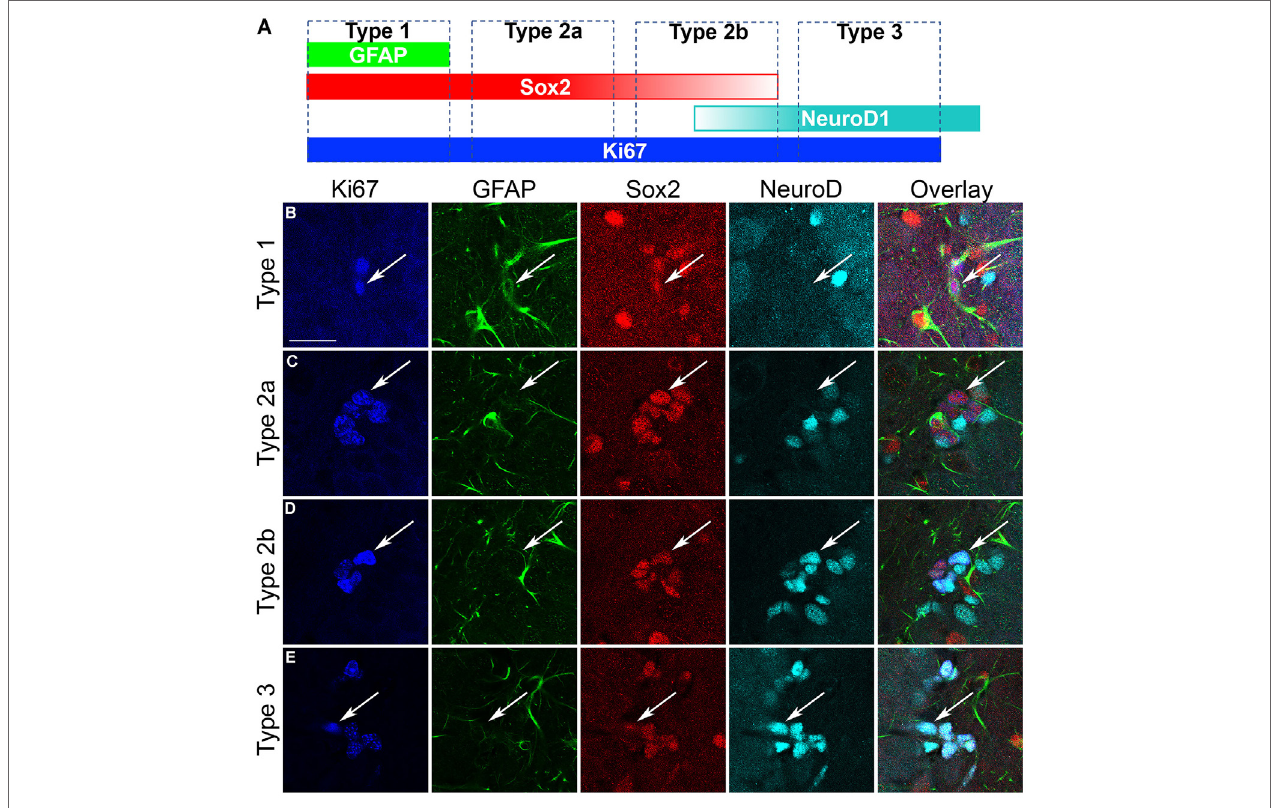
FigUre 4 | Characterization of hippocampal neural progenitor cells. (a) Quadruple fluorescent immunohistochemistry was applied to identify each of the various progenitor cell subtypes as defined in the schematic as follows: GFAP + /Sox2 + /NeuroD1 − cells are considered as type 1; GFAP − /Sox2 + /NeuroD1 − cells are considered as type 2a; GFAP − /Sox2 + /NeuroD1 + cells are considered as type 2b; GFAP − /Sox2 − /NeuroD1 + cells are considered as type 3 cells. (B–e) Representative confocal images of each of the subtypes show Ki67 + cells colabeled with GFAP, Sox2, and/or NeuroD1 according to that defined in (a) . Scale bars = 20